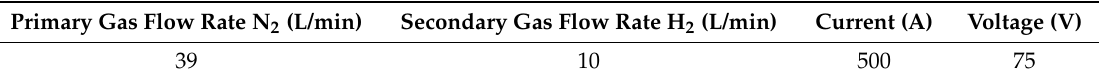
Table 1. Process parameters of 9M plasma jet.